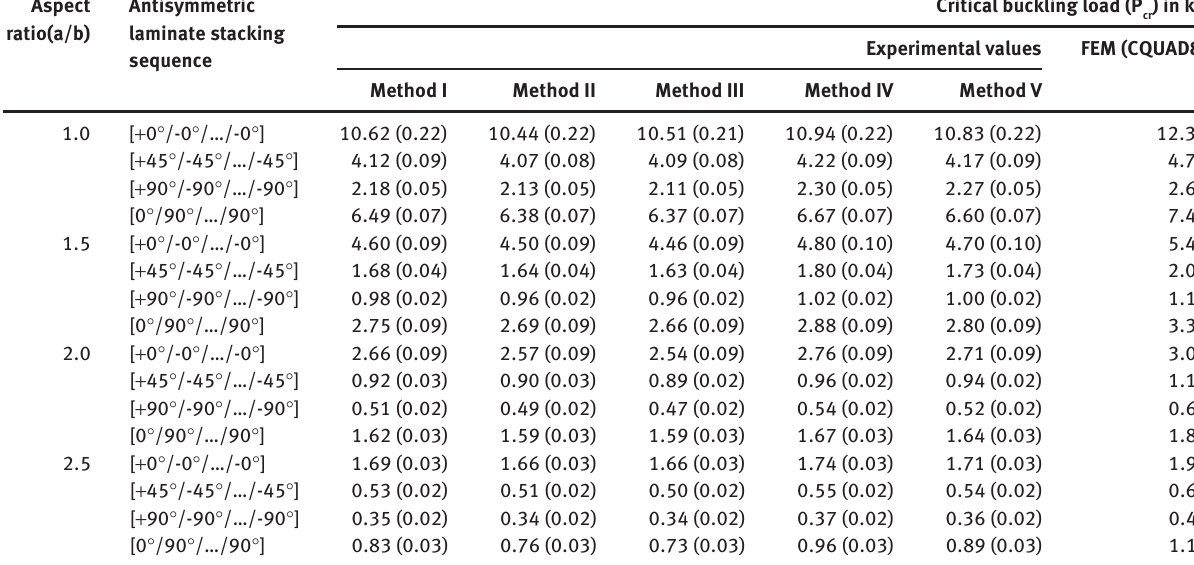
Table 3 Critical buckling load for laminated skew plate ( α = 15 ° ).